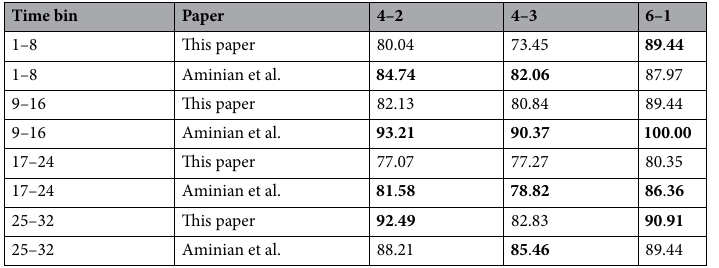
Table 5. Classifications balanced success rates of SVM in a LOSO experiment on test data across different experiments within 32 hours after infection. The highest values for each experiment and time bin are in bold. All experiments in this table use LIMMA normalization on subject identifier. The majority of the best results from this paper are using